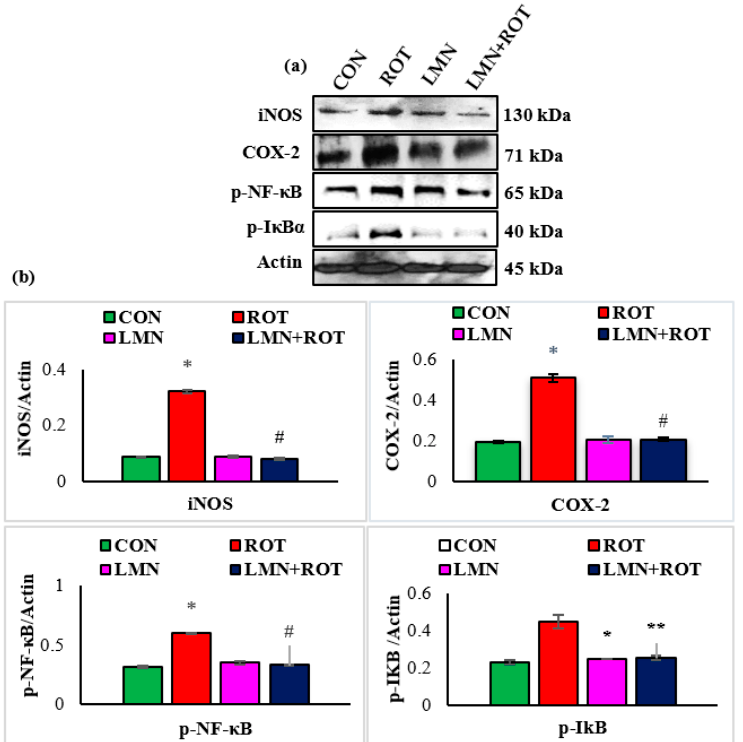
Figure 7. Immunoblotting analysis and quantification of iNOS, COX-2, and p-NF- κ B in the striatal tissues of rats ( a , b ). Immunoblotting was performed in duplicate and the results are presented as mean ± SEM. * p < 0.05 CON vs. ROT; # p < 0.05 ROT vs. LMN + ROT (one-way ANOVA followed by DMRT). CON: normal control, ROT: rotenone, LMN: limonene, LMN + ROT: limonene and rotenone treatment.